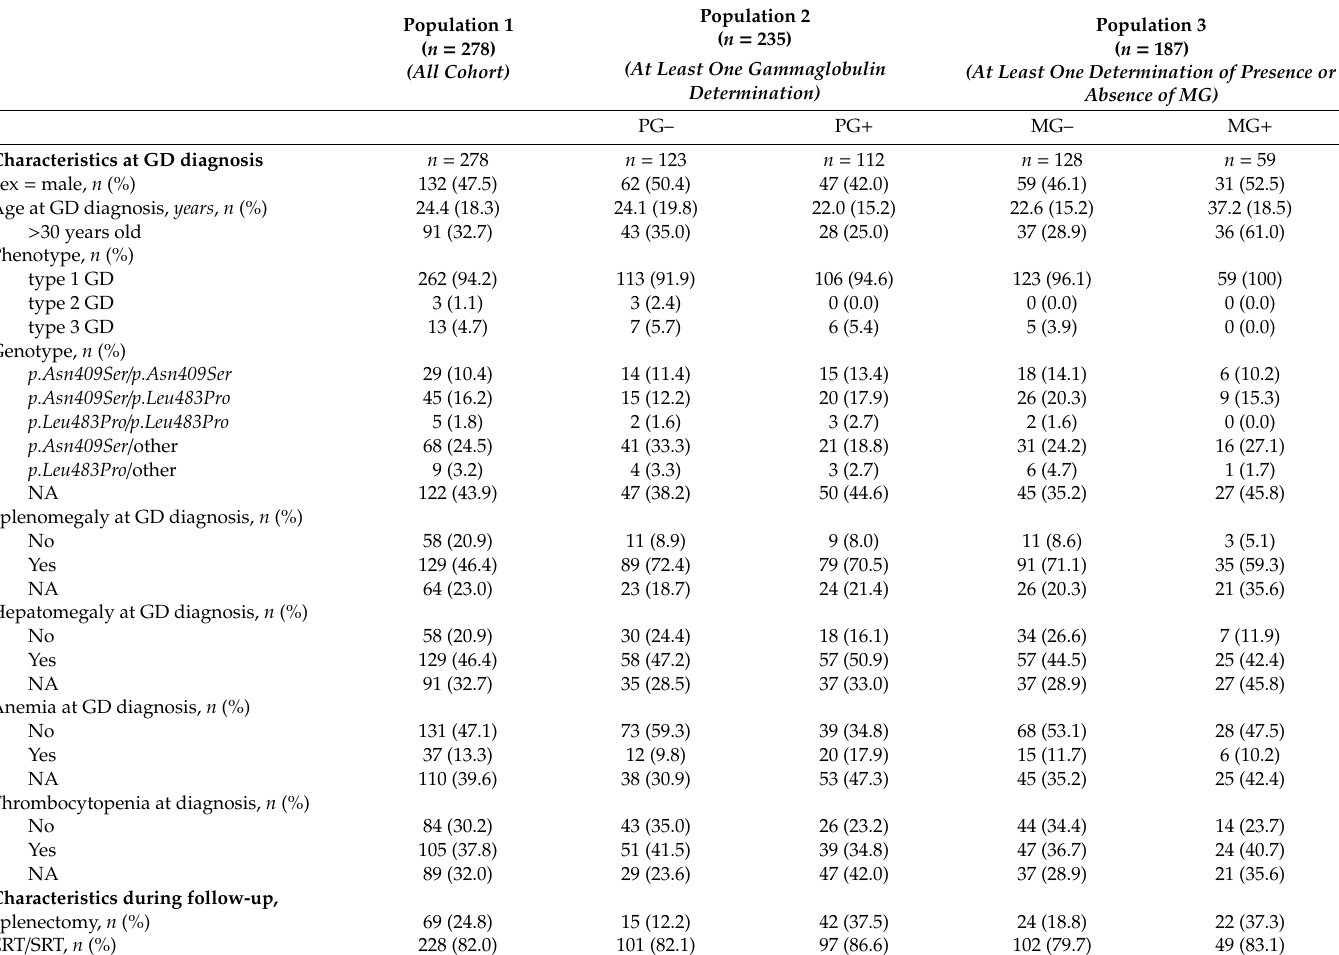
Table 1. Baseline characteristics of participants with Gaucher disease (GD) with or without polyclonal gammopathy (PG) or monoclonal gammopathy